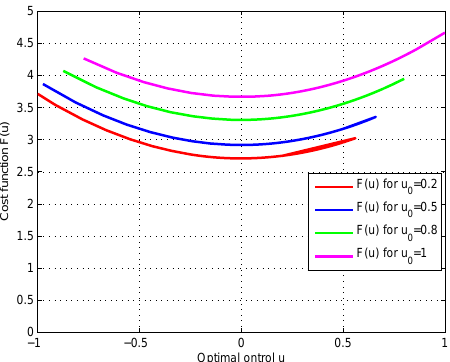
Fig. 6. Numerical Simulations of the control u and the function cost F ( u ) for the different initials values of u 0 . We obtain: If u 0 = 0 . 2 then F ( u ∗ ) = 2 . 7073